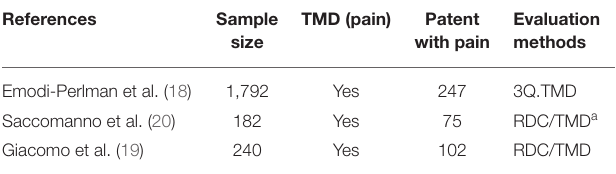
TABLE 2 | Evaluation of TMD (pain) frequency in studies.